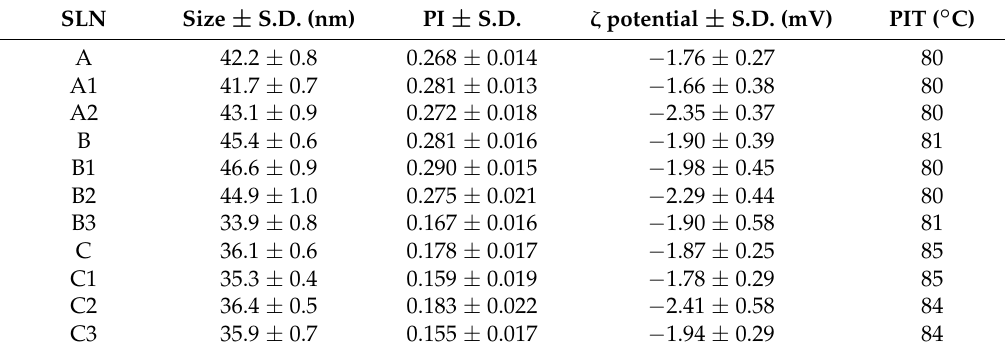
Table 1. Characterization of unloaded and IDE-loaded SLN: particle size (size ± S.D.),